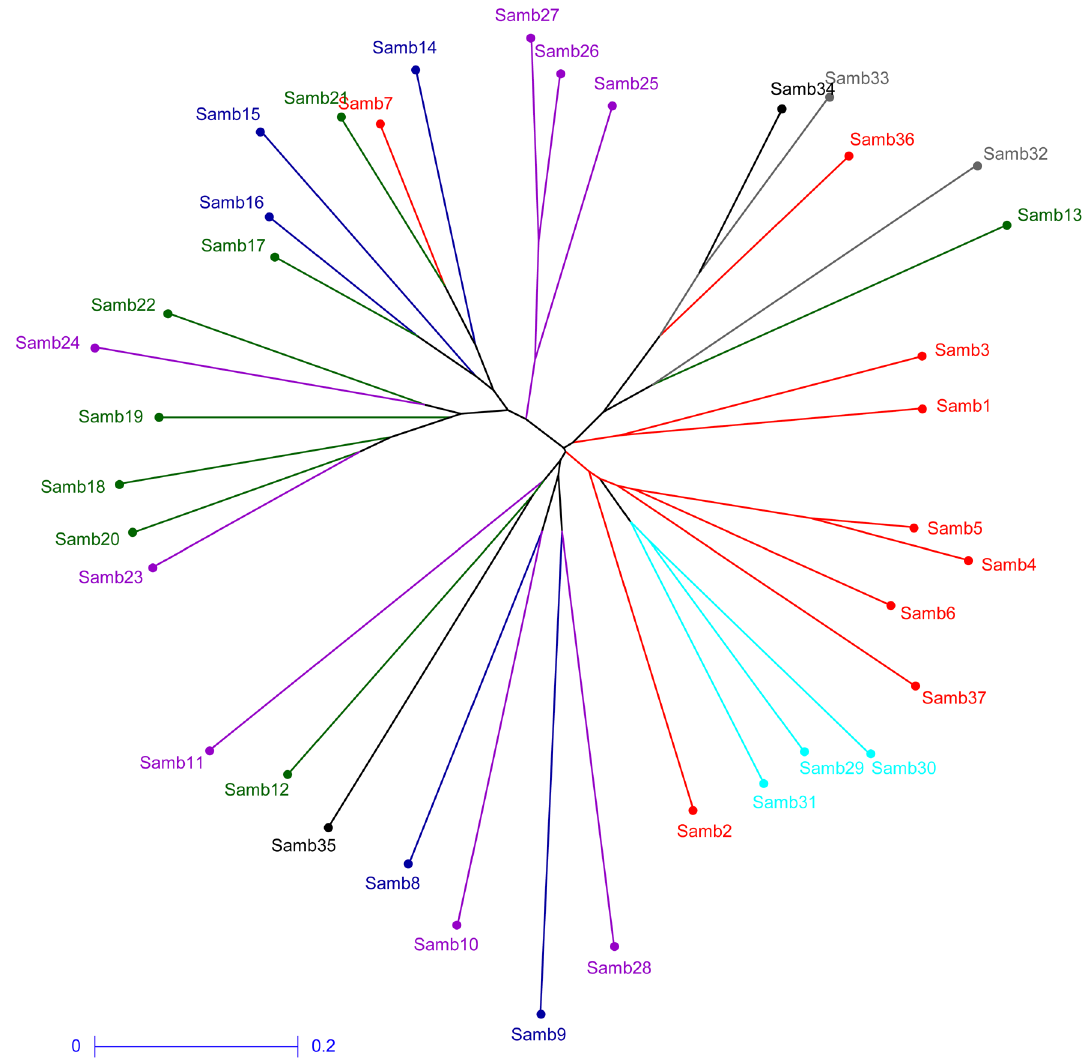
Figure 1. UNJ dendrogram showing clustering pattern of S. wightiana Samples (DARwin ver. 6.0; http:// darwin. cirad. fr/